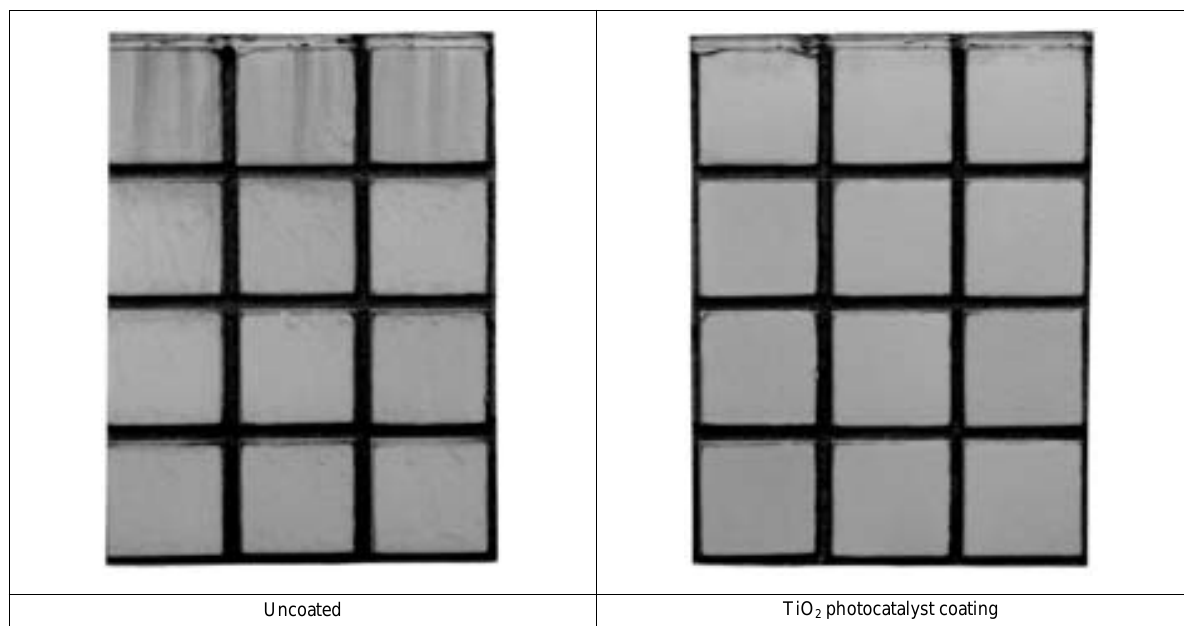
Fig. 4 Self-cleaning effect of wall tiles coated with TiO 2 photocatalyst (1 year after installation: top joint is filled with silicone